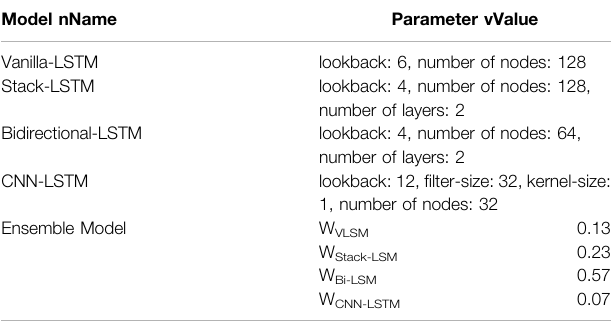
TABLE 3 | Calibrated parameter values obtained from the grid-search method in training dataset.